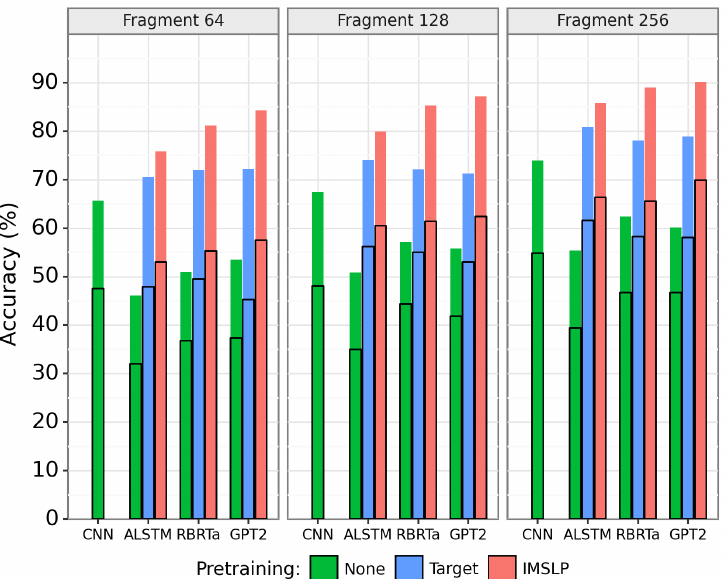
Figure 4. Results on the fragment classification task. For each model architecture, the green (leftmost), blue (center), and red (rightmost) bars show the performance with no pretraining, target pretraining, and full IMSLP pretraining, respectively. Colored bars indicate performance with both training and test time data augmentation ( K = 3, L = 2), and black rectangles indicate performance without augmentation ( K = 0, L =